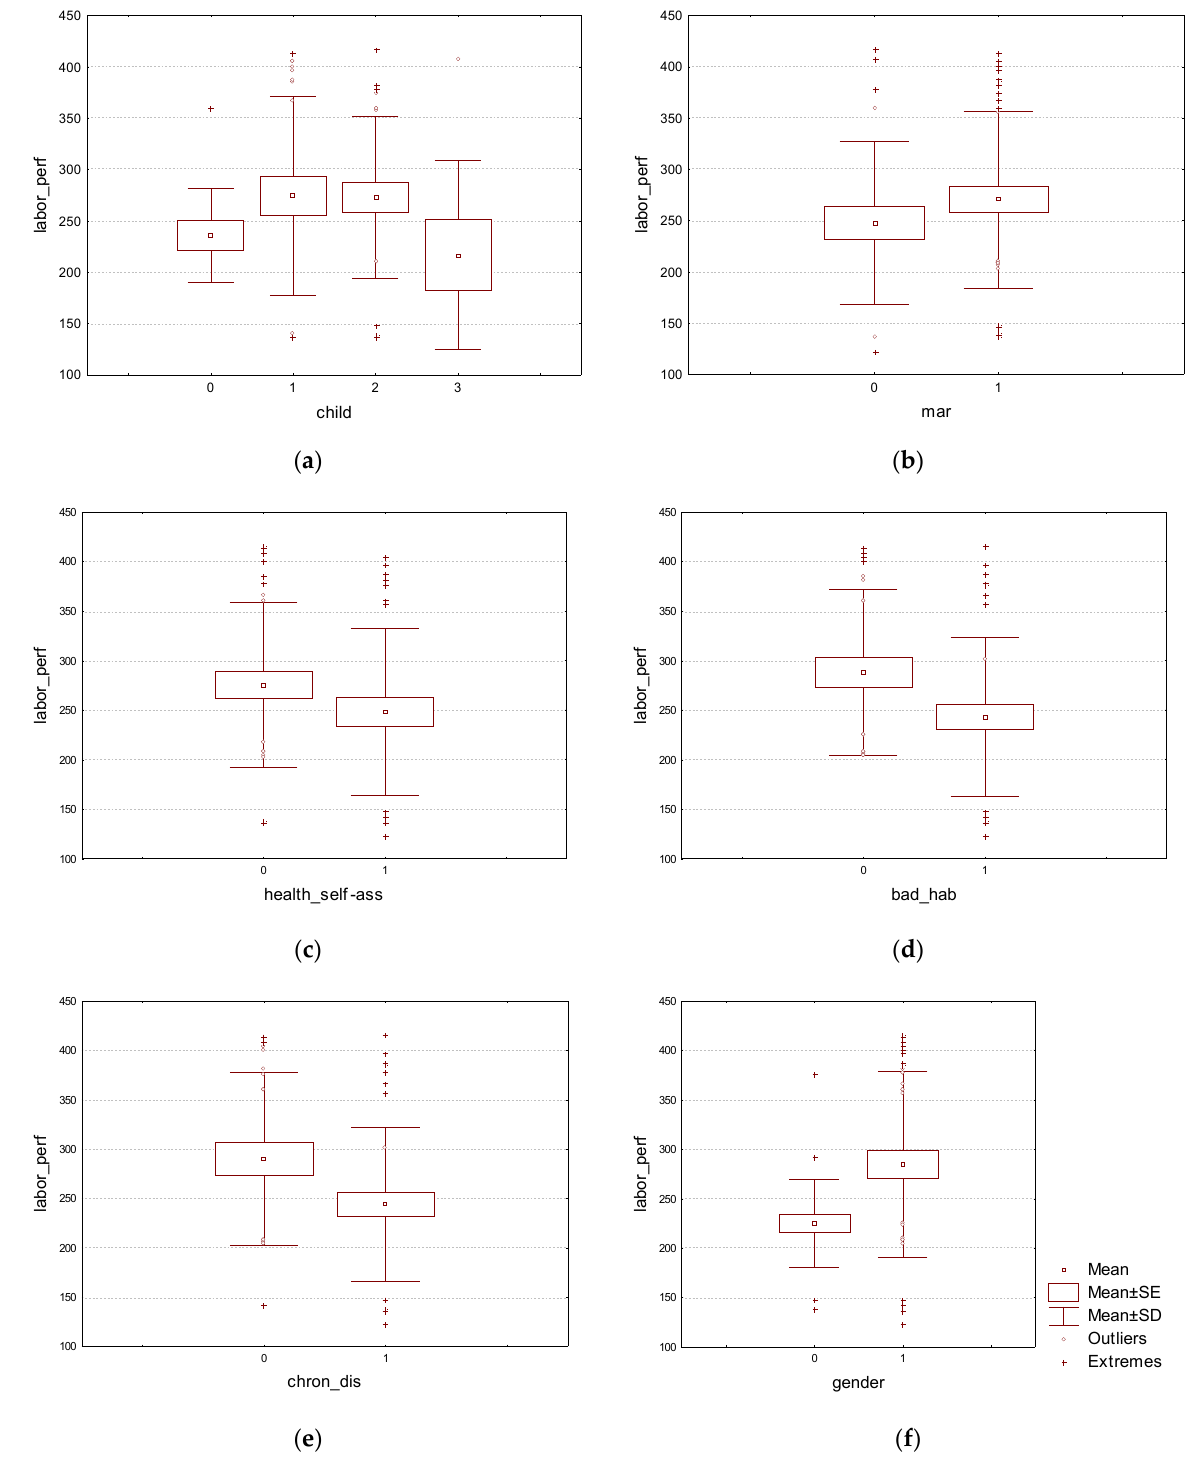
Figure 2. Whiskers diagrams for the factor groups “child and labor_perf” ( a ), “mar and labor_perf” ( b ), “health_self-ass and labor_perf” ( c ), “bad_hab and labor_perf” ( d ), “chron_dis and labor_perf” ( e ), “gender and labor_perf” ( f ). Diagrams show that different levels of the factors gender, child, health_self-ass and bad_hab determine the difference in the labor productivity indicator—labor_perf. Thus, men have higher average labor productivity, about 280 rubles per hour than women—225 rubles per hour. Those personnel who do not have chronic diseases do not often feel unwell and do not have bad habits; their average level of labor productivity is higher than